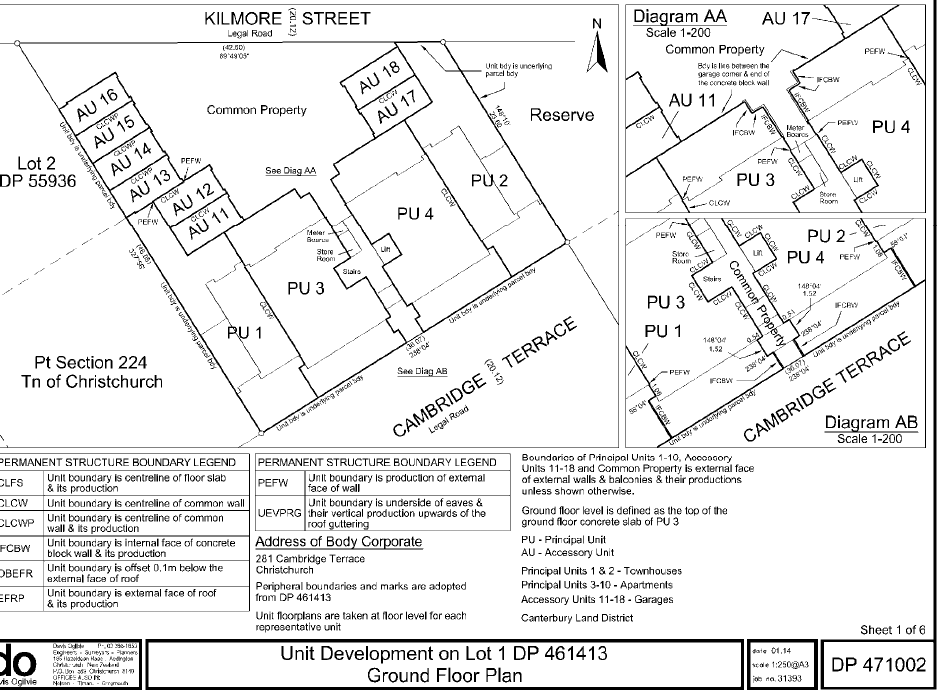
Figure 5. Plan view of unit title development.